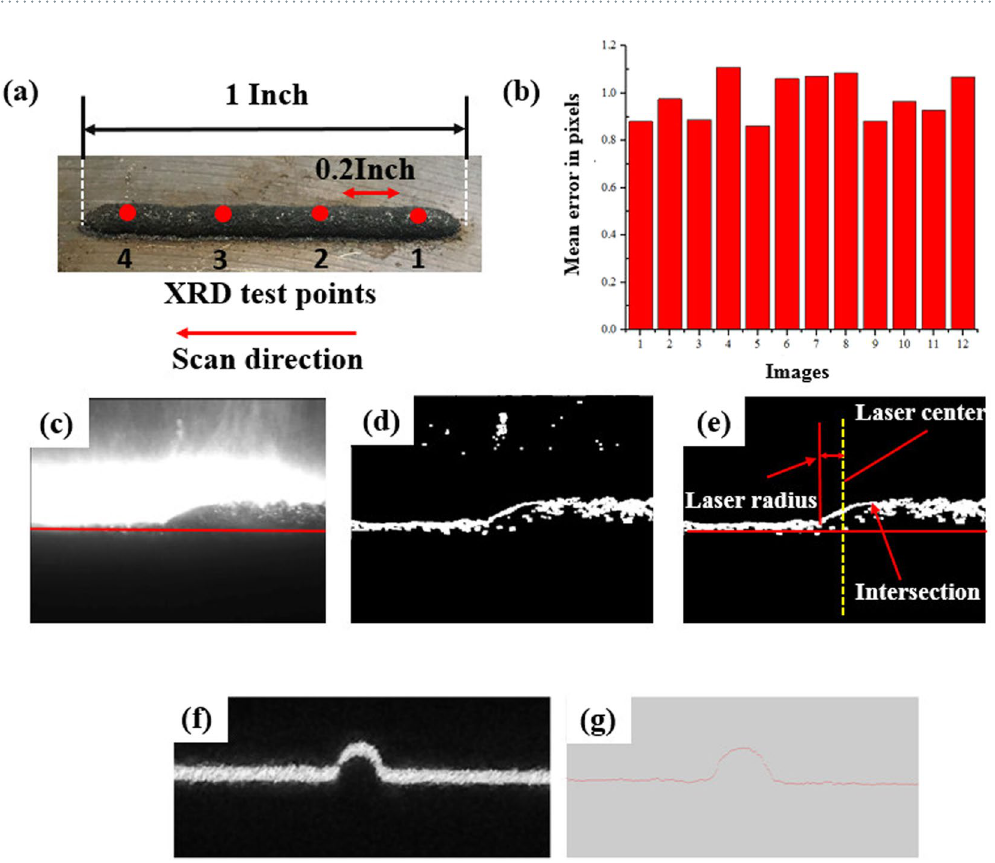
Figure 4. The melt pool image, ( a ) deposited sample, ( b ) mean error in pixels, ( c ) original image, ( d ) edge detection, ( e ) apply